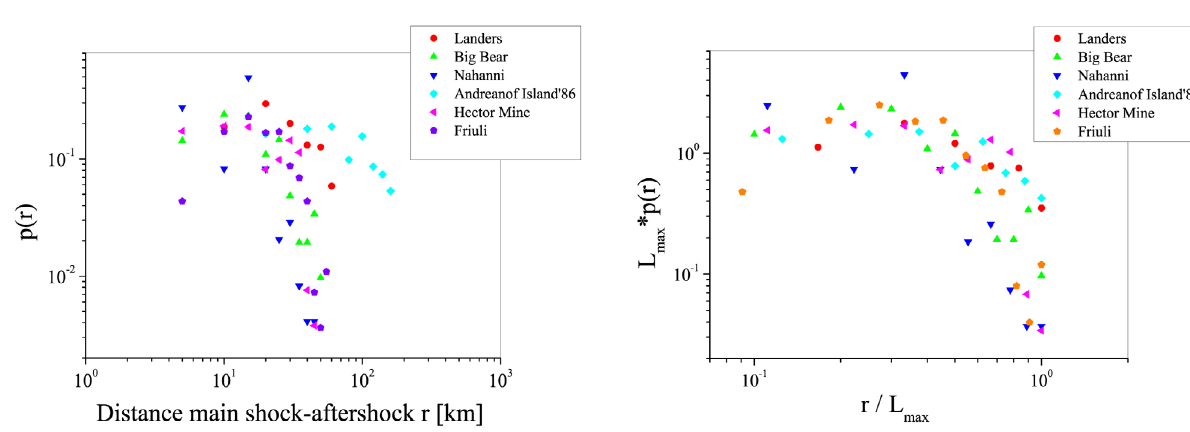
Figure 4. Probability density for the rescaled data: x = r / L * P ( r ) – r main shock-aftershock distance, for the selected earth- L max quakes.